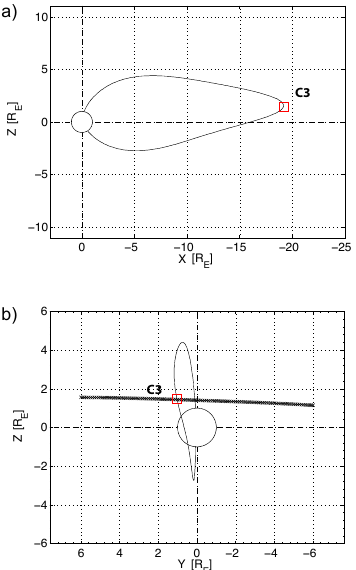
Figure 5. (a – b) Location of the Cluster 3 spacecraft (red square) in the GSM coordinate system at 11:26UT on 5 September 2001. The solid loop indicates the T96 model field line traced through the spacecraft position. (b) The thick black line indicates the TF04 model neutral sheet in the GSW coordinate system at the C3 XGSW distance where the C3 XGSW coordinate is approximated by its XGSM